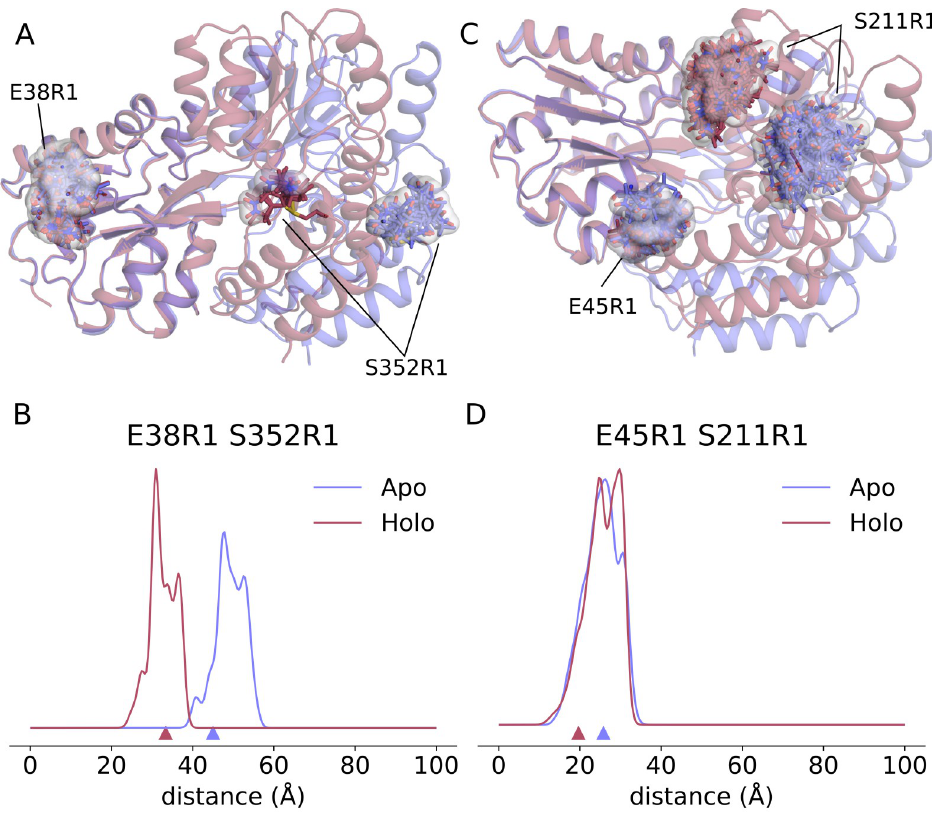
Fig 3. Illustration of how changes in backbone do not necessarily cause changes in distance distributions. Top: Comparison of apo (blue, PDBID 1OMP) and holo (red, PDBID 1ANF) MBP structures and the locations of the model R1 spin labels (sticks) for the site pairs E38R1 S352R1 (A) and E45R1 S211R1 (B). Bottom: Comparison of apo and holo distance distributions for the two site pairs that both show significant changes in C β –C β backbone distance, indicated by small triangles at the base of the plots. The E38R1 S352R1 site pair on the left (C) shows a clear difference in the predicted distributions while the E45R1 S211R1 site pair on the right (D) shows very little change.